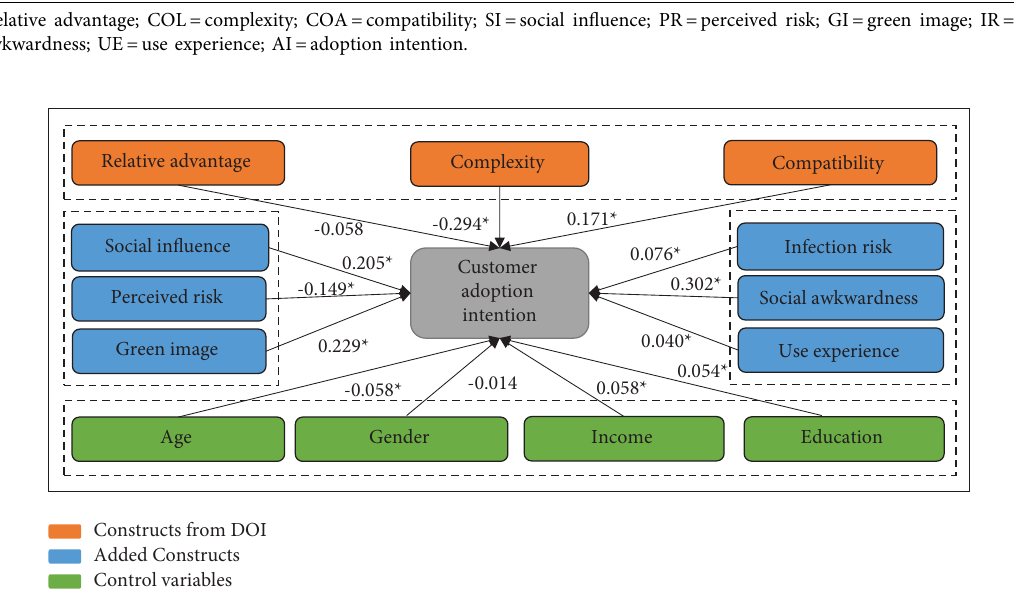
Figure 4: Results of path analysis. Notes: ∗ means that this attribute is a signifcant contributor according to the analysis. Table 9: Control variable